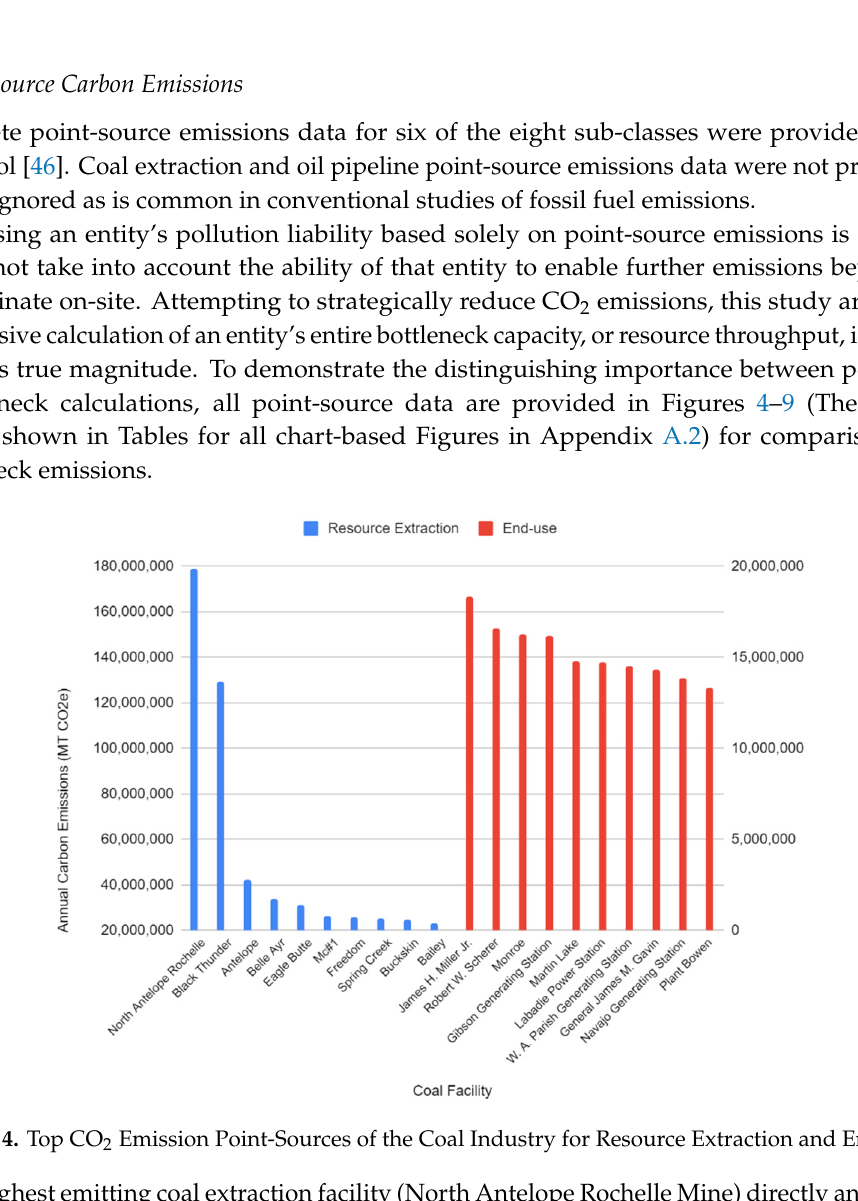
Table 1. The eight classes of GHG emitting entities evaluated.